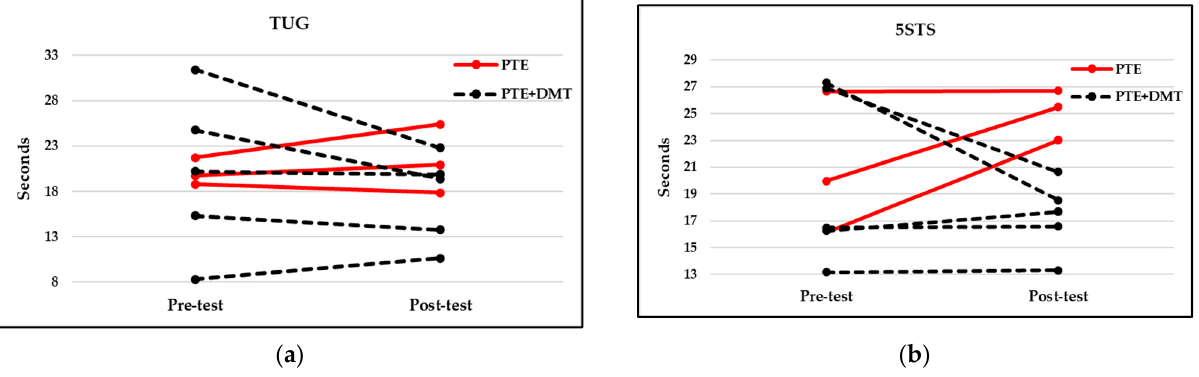
Figure 1. ( a ) Participant scores change of TUG test; ( b ) participant scores change of 5STS test.